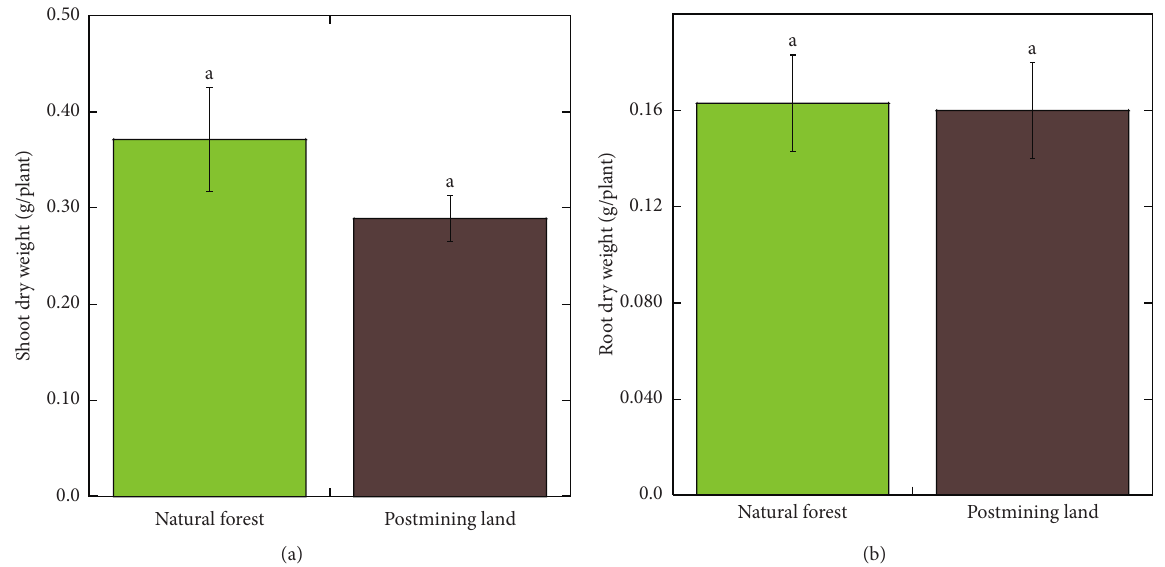
Figure 5: Shoot dry weight (a) and root dry weight (b) of Albizia saman grown on natural forest soils or post bauxite mining soils for 15 weeks under greenhouse conditions. Different letters of each column chart indicate a significant difference ( P < 0 . 05) by the t test. Mean ± standard error is shown ( n � 15).